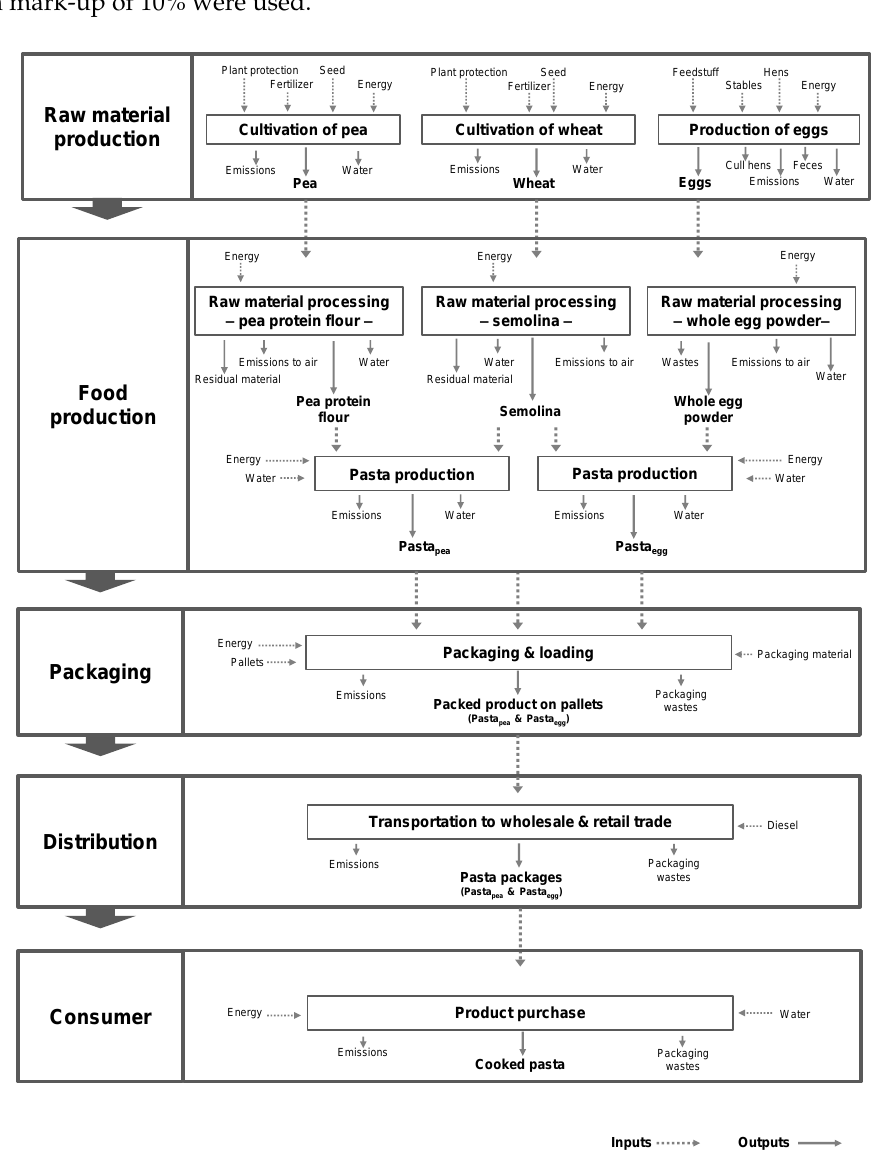
Figure 1. The value chain of the pasta production for Pasta egg and Pasta pea .